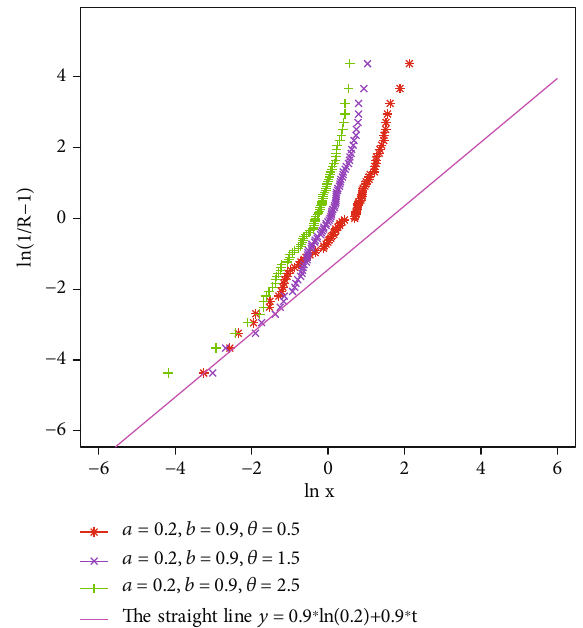
Figure 3: The LLP for three simulated samples from the MLL model. The straight line shows the corresponding LLP of the LL